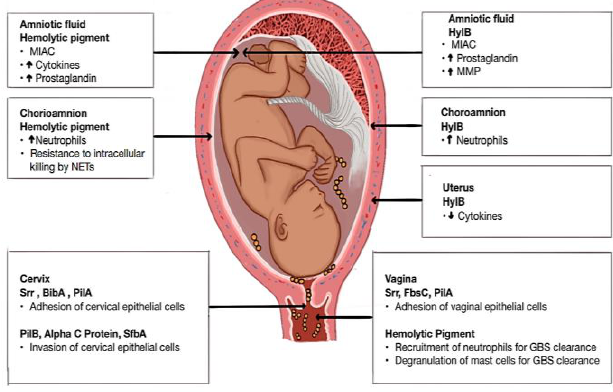
Figure 2: During vaginal colonization, GBS adhesins including Srr, FbsC and PilA bind to ligands on the surface of vaginal epithelial cells. Hemolytic pigment mediates the recruitment of neutrophils into vagina, and the degranulation of mast cells to restrict GBS vaginal colonization. Srr, BibA and PilA are necessary for GBS adhesion of cervical epithelial cells. Alpha C protein, PilB and SfbA meanwhile are crucial for GBS invasion of the cervical epithelial cells to possibly mediate GBS transition, from an asymptomatic colonizer to an invasive pathogen and thus facilitating GBS invasion of amniotic fluid. In uterus, HylB dampens the synthesis of proinflammatory cytokines to probably allow for GBS ascending intrauterine infection. Hemolytic pigment and HylB mediate the recruitment of neutrophils into choriomanion. Hemolytic pigment allows GBS to circumvent NETs in chorioamnion, as one of the mechanisms to evade host immune response. Then both hemolytic pigment and HylB are shown to cause the GBS invasion of amniotic fluid, and these virulence factors then further trigger the synthesis of cytokines, MMP and prostaglandin in amniotic